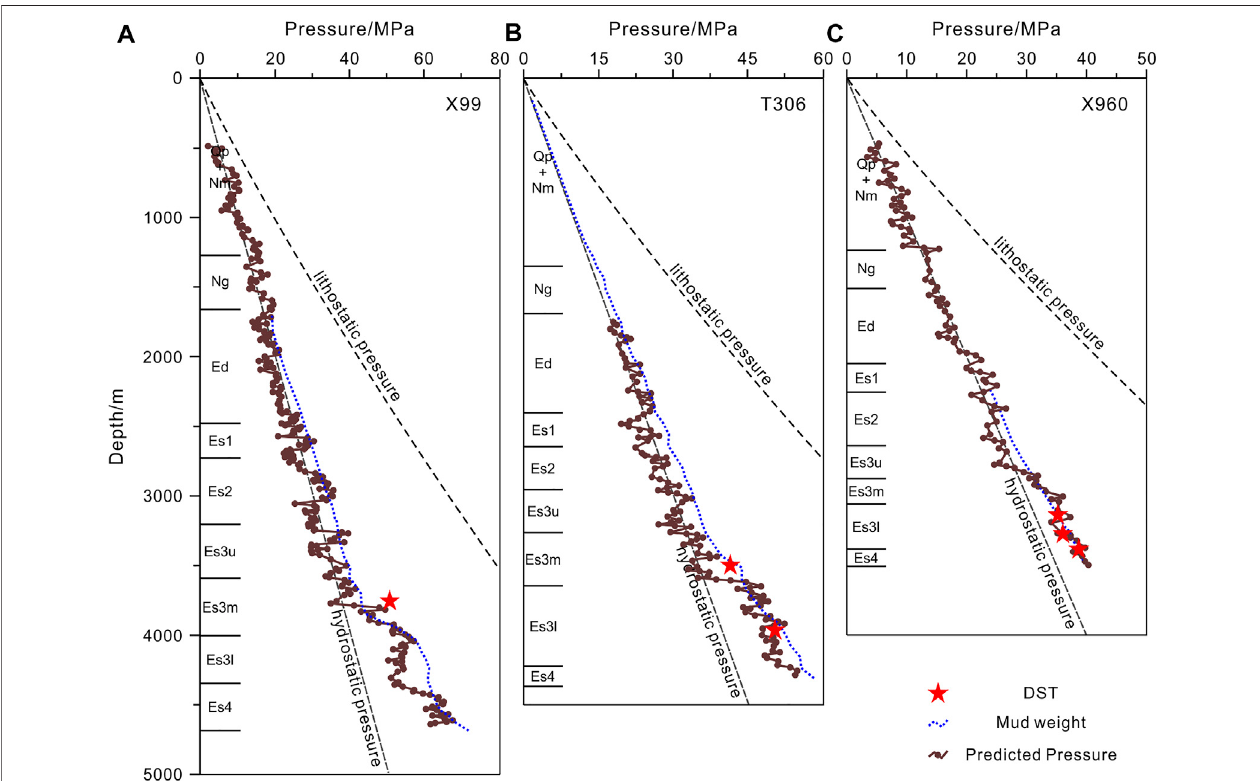
FIGURE 13 | Pore prediction results of mudstones using the equivalent depth method in the Linnan Sag for well (A) X99, (B) T306, and (C) XX960. The measured pressures and mud weights are also shown for comparison. The well locations are shown in Figure 1 .